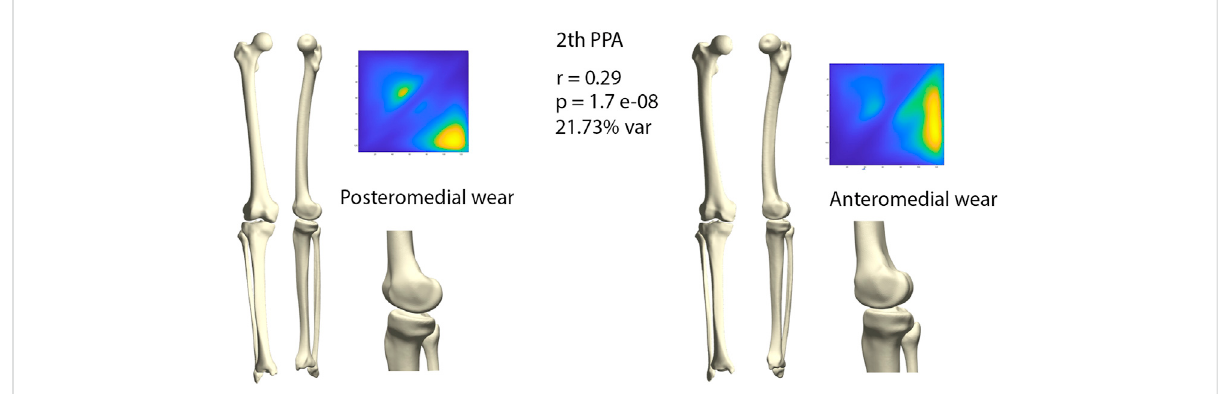
FIGURE 7 Comparison of limb geometry corresponding with posteromedial (left) and anteromedial (right) cartilage wear. Posteromedial wear is correlated with neutral to varus alignment, increased tibial slope and external tibial torsion. Anteromedial wear is correlated with a constitutional varus, increased femur bowing, decreased femoral torsion and a neutral tibial slope. For visualization purposes, differences obtained following the canonical correlation analysis were ampli fi ed with a factor